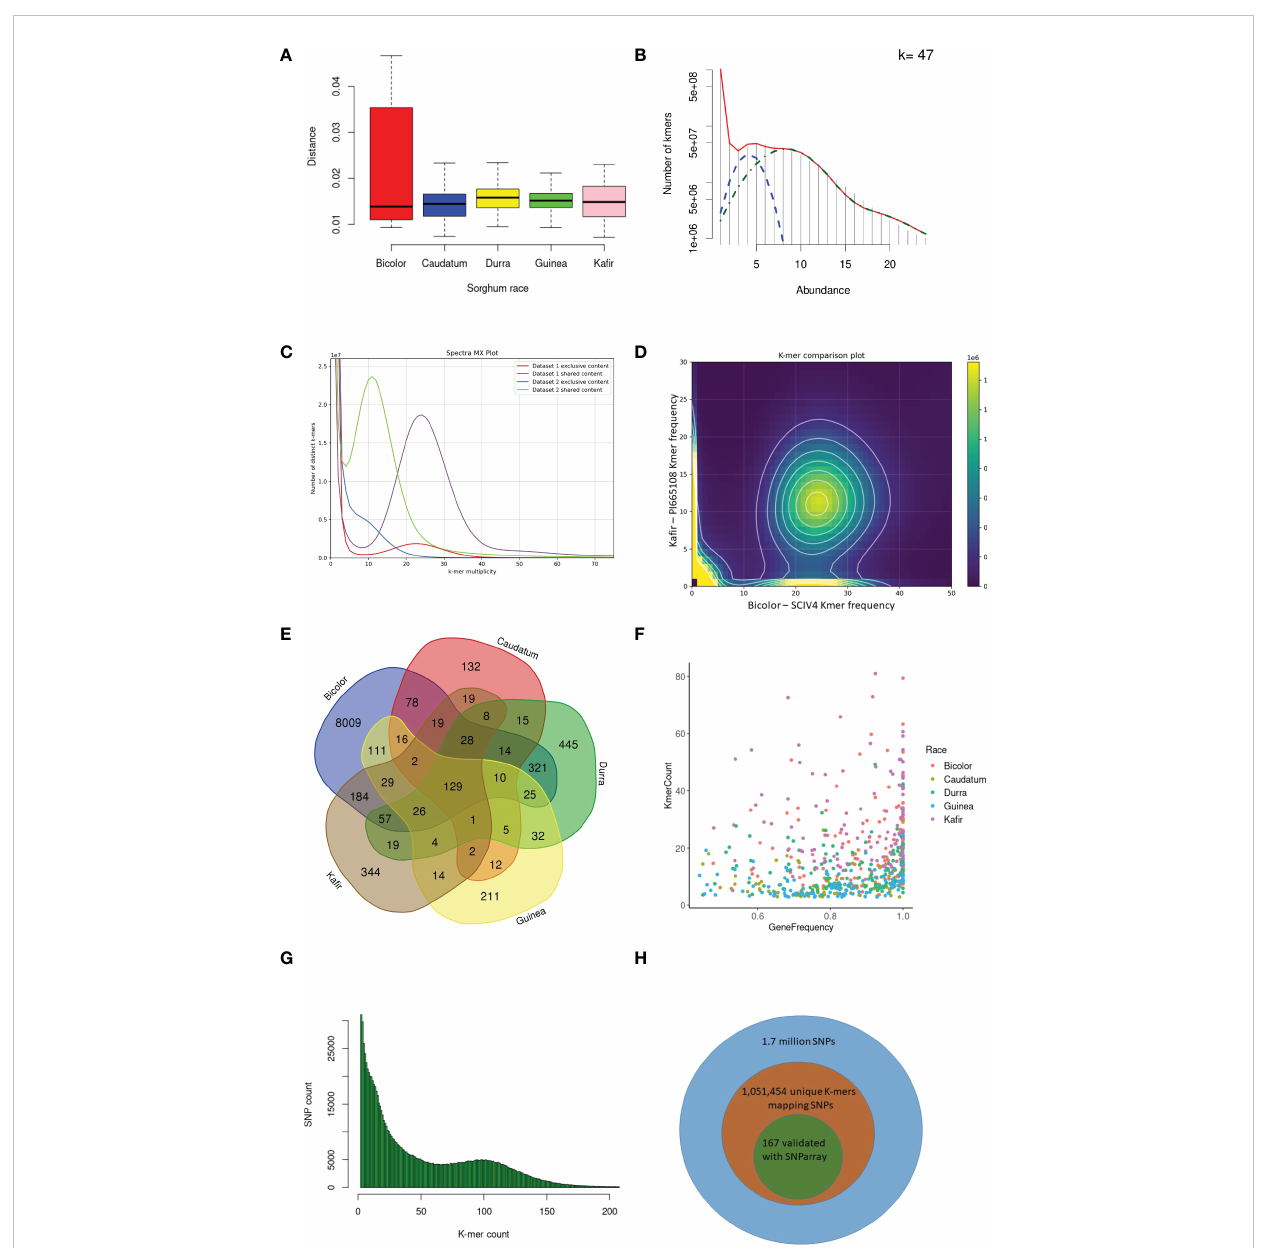
FIGURE 2 K-mer and read mapping overview. (A) An alignment-free method, the Jaccard index uses the hash procedure to measure the distance between sorghum race accessions. (B) Sampled histogram and fi t for 47 k-mer lengths. Red is the fi t of the complete statistical model of the histogram, blue is the heterozygous k-mers and green is the only homozygous k-mers (C) The k-mers share between ka fi r (PI665108) and bicolor (SCIV4) sorghum race accessions as dataset1 and dataset2 respectively. (D) Distinct k-mer share between ka fi r and sorghum race, the cloud indicates the shared k- mers and heigh density k-mers on x and y-axis are unique k-mers respectively. (E) Mapped k-mer sequence reads in the number of genes in each sorghum race accessions (F) Proportion of sorghum race common genes covered with horizontal and vertical coverage with k-mer sequence reads. (G) The unique k-mer s holding the deepvariant SNPs with respective k-mer count and off these, (H) the proportion of deepvariant SNPs